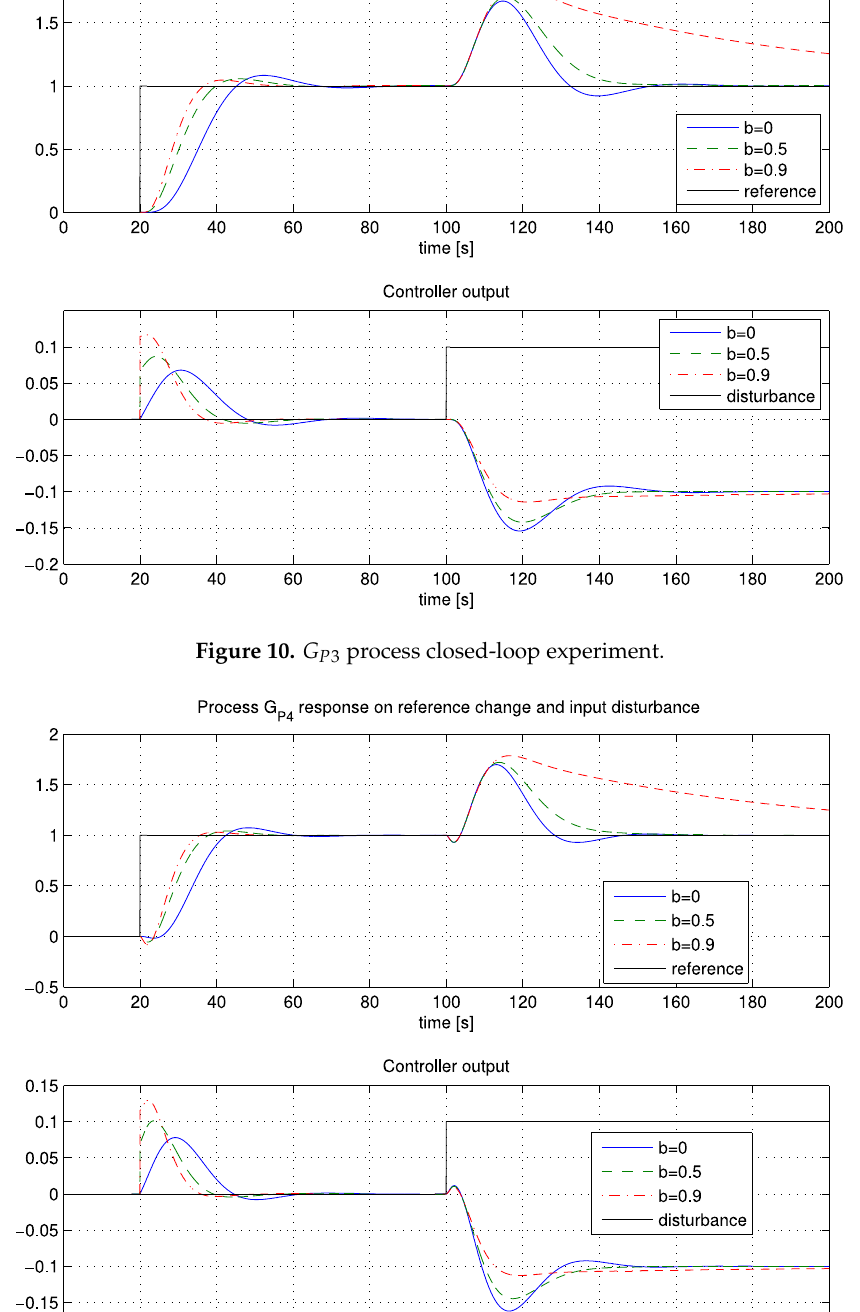
Figure 9. G P 2 process closed-loop experiment.